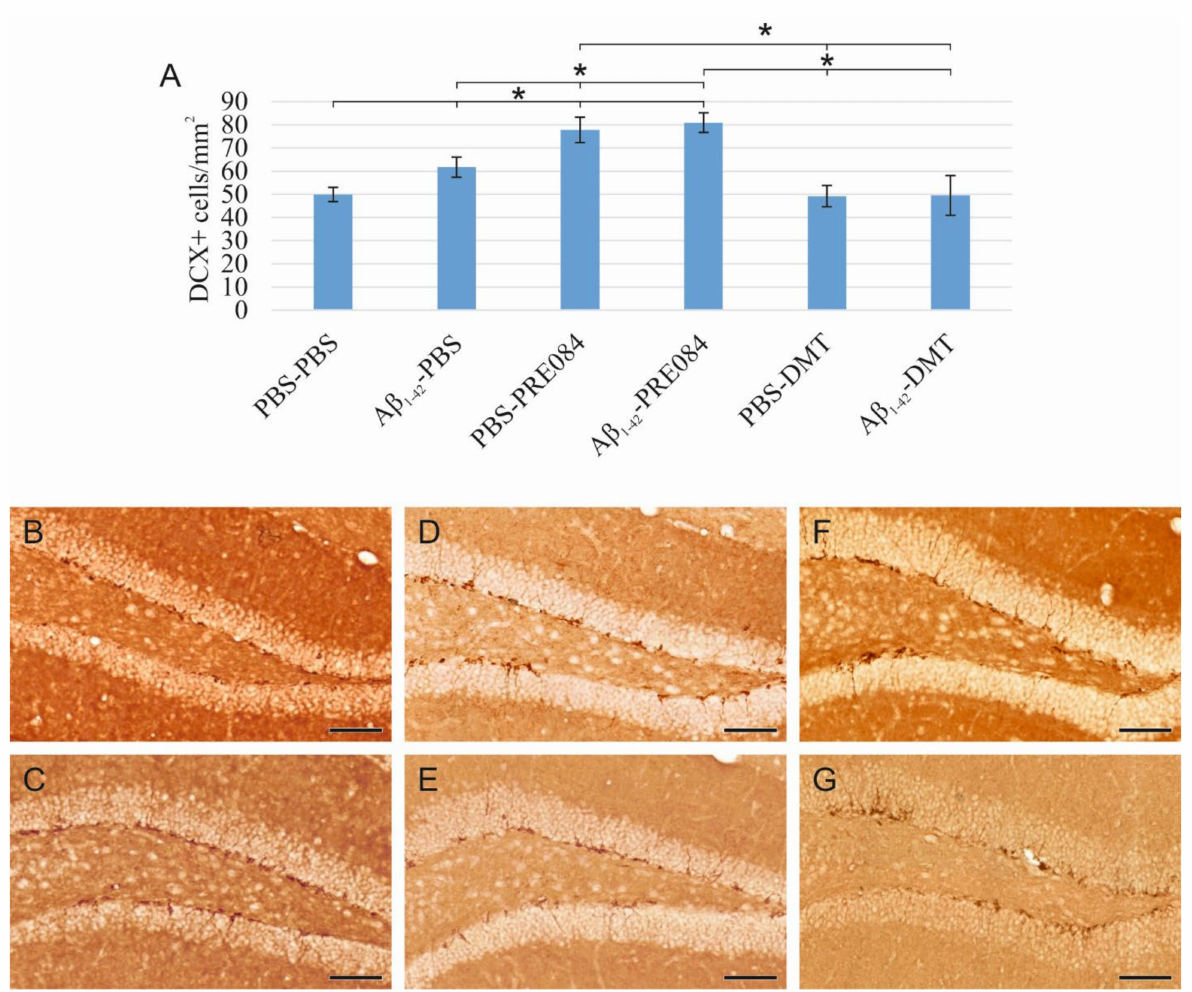
Figure 2. ( A ) Results for doublecortin (DCX) immunostaining. Detected DCX densities